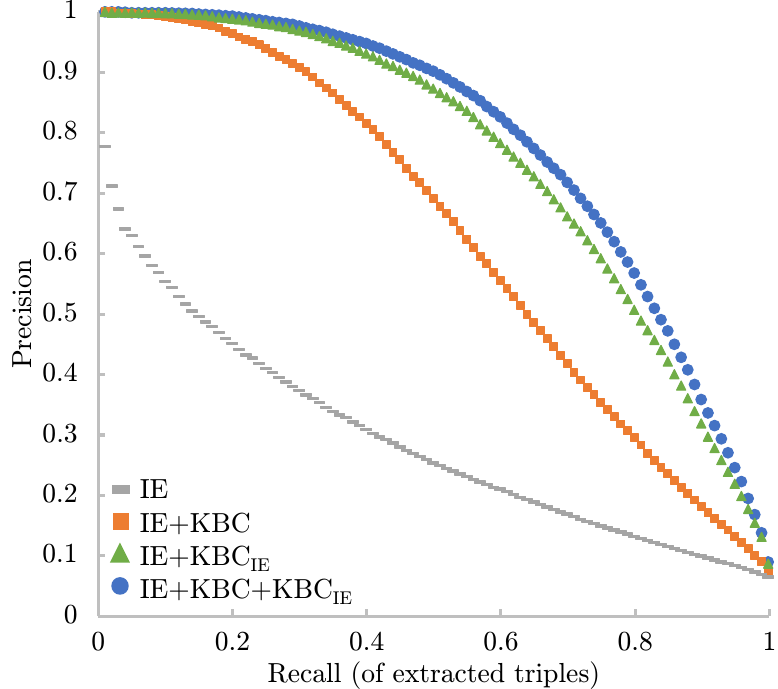
Figure 4. Precision recall curves for